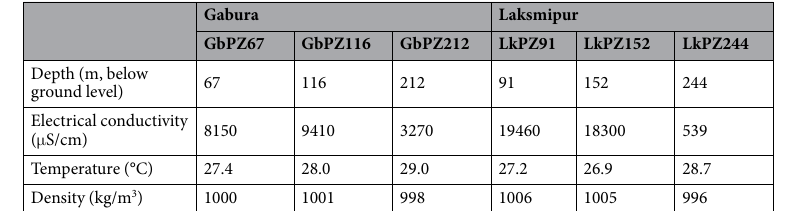
; in (g) the 075 0 C 0